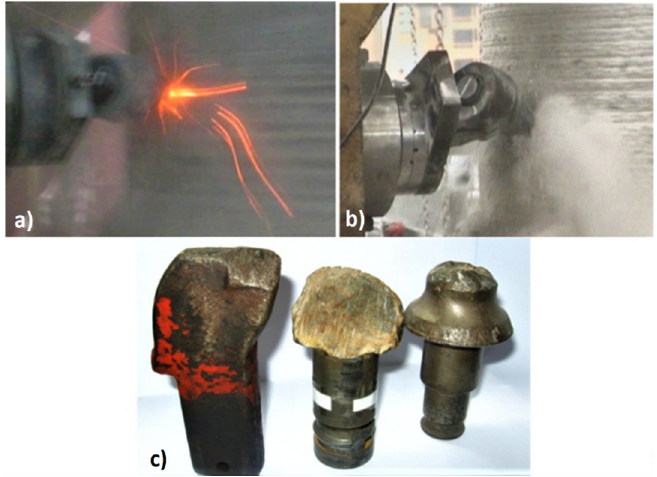
Figure 1. View of the threats generated during cutting of a rock sample with cutting tools: ( a ) frictional sparking, ( b ) dust generation, ( c ) pick edge wear [2].